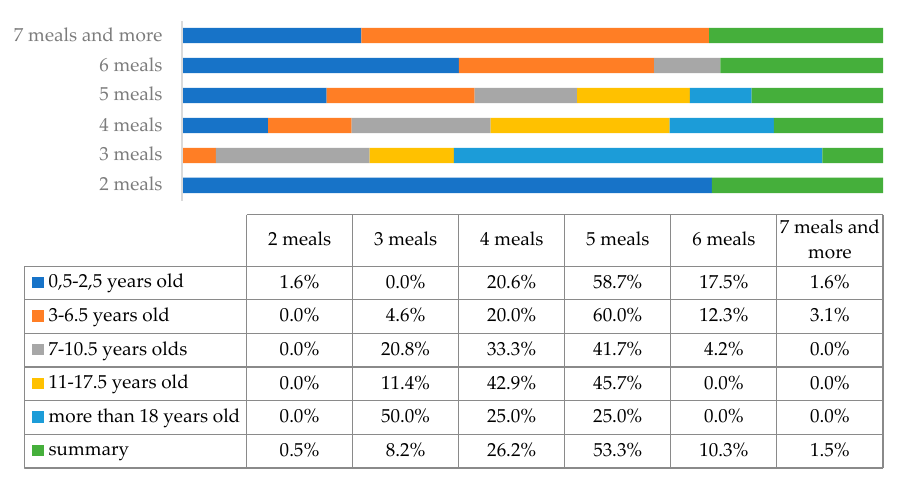
Figure 8. A number of meals consumed per day in the study group of individuals with DS by age.